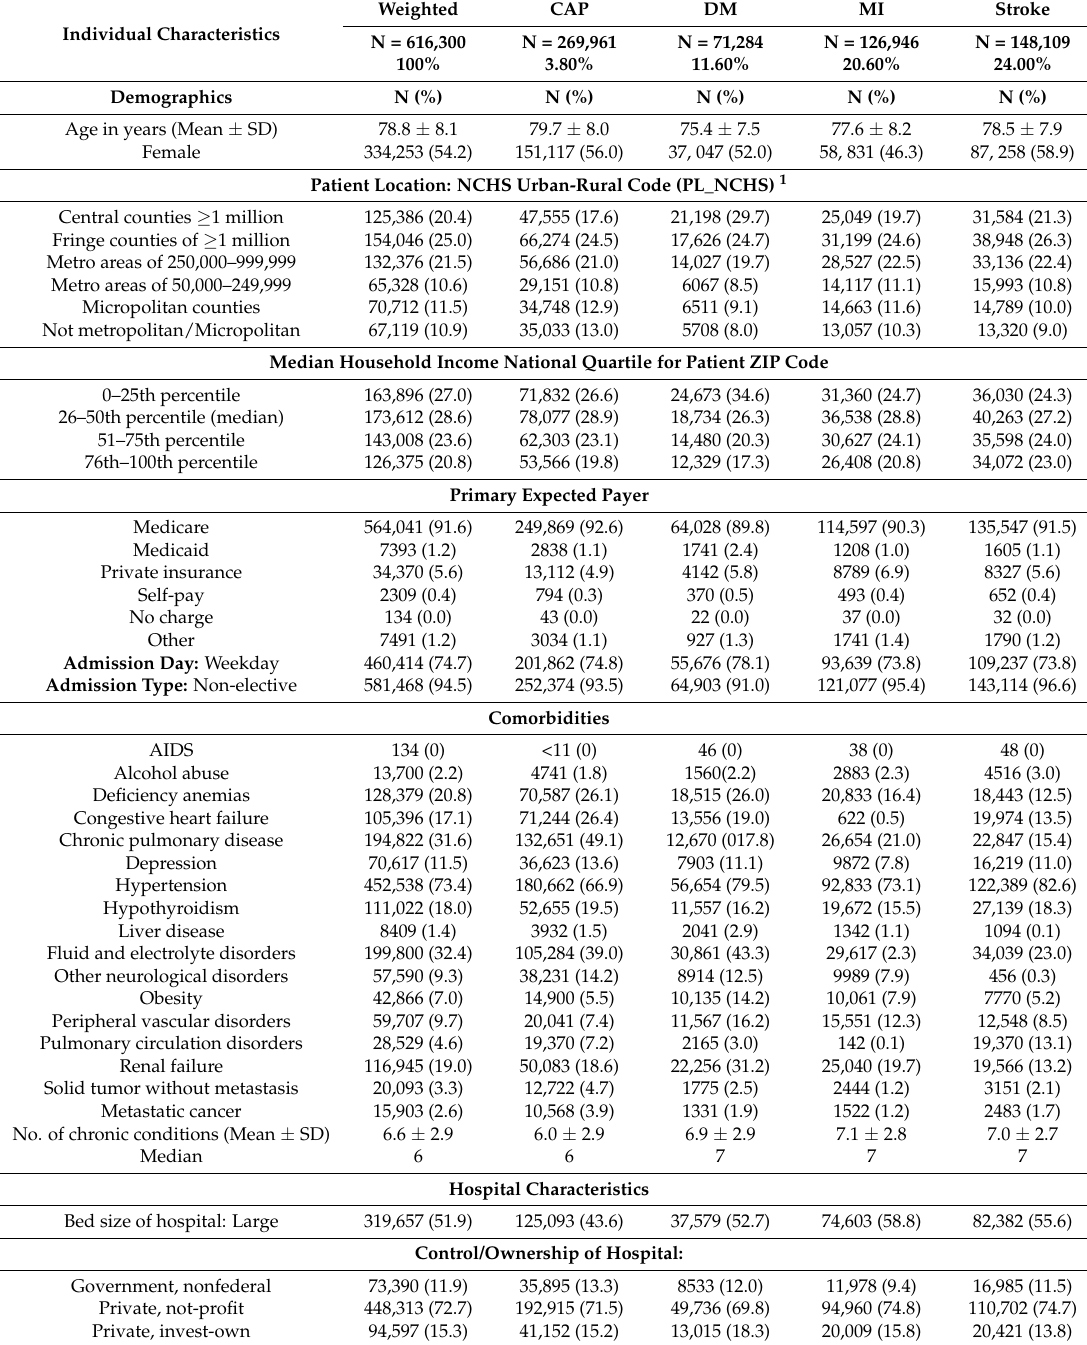
Table 1. Characteristics of the study population 65 years and older with a hospitalization discharge for community-acquired pneumonia (CAP), diabetes mellitus (DM), myocardial infarction (MI), or stroke, weighted national estimates in 2014 Nationwide Readmissions Database, United